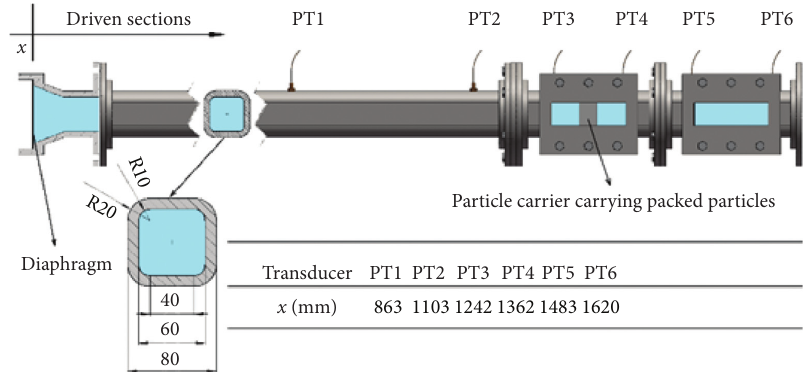
Figure 1: Front view schematic of the driven section of the shock tube.